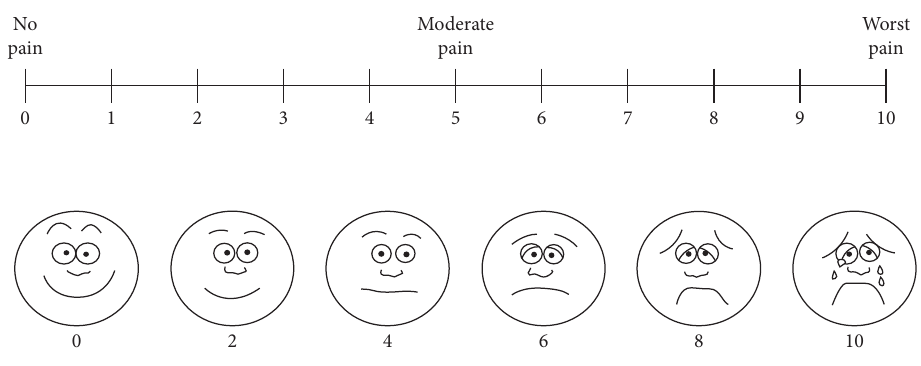
Figure 3: VAS index to evaluate